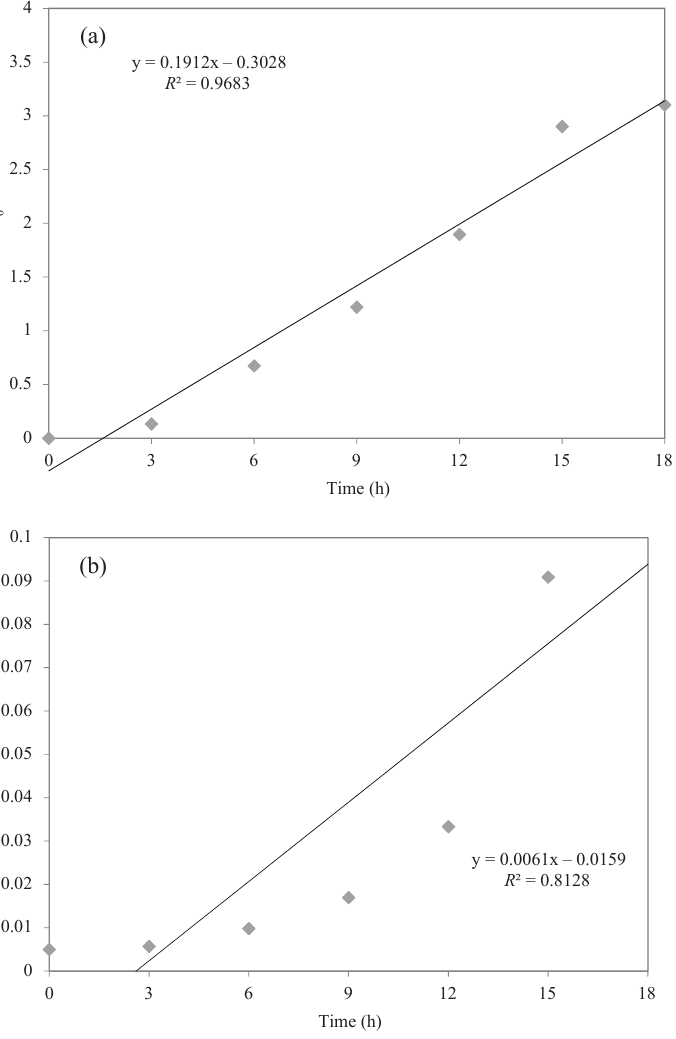
Fig. 2 – Kinetic analysis for persulfate-assisted EK of pyrene: 200 mg kg –1 , Tween 80: 20 mL kg –1 , pH: 7± 0.3, reac- tion time: 24 h, voltage: 1 V cm –1 , moisture content: 100 %